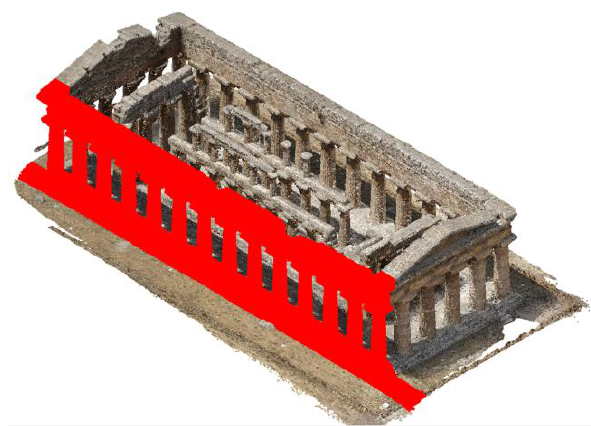
Figure 2 . Photogrammetric Point cloud and section analysed (in